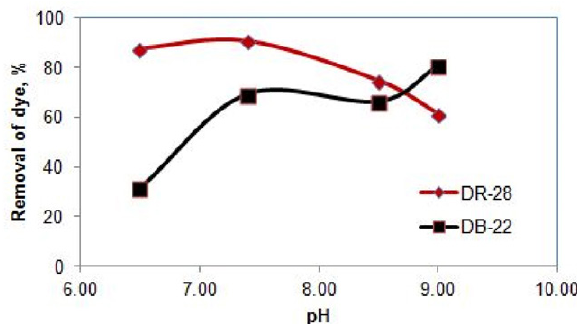
Fig. 7. Effect of initial pH of the dye solution on the removal of DR- 28 and DB-22 (initial concentration: 30 mg/L, temperature: 21 °C, adsorbent: KZF, adsorbent amount: 1g/200mL, contact time: 60 min)